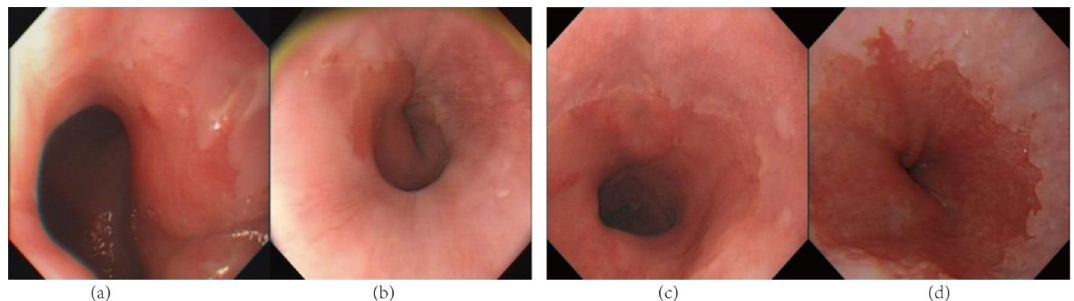
Figure 2. Example of a filtered possible error image. ( a ) True Positive; ( b ) False Negative; ( c ) False Positive; ( d ) True Negative. The screened image is the image with high error rate of each screening and the image cannot be correctly classified by the